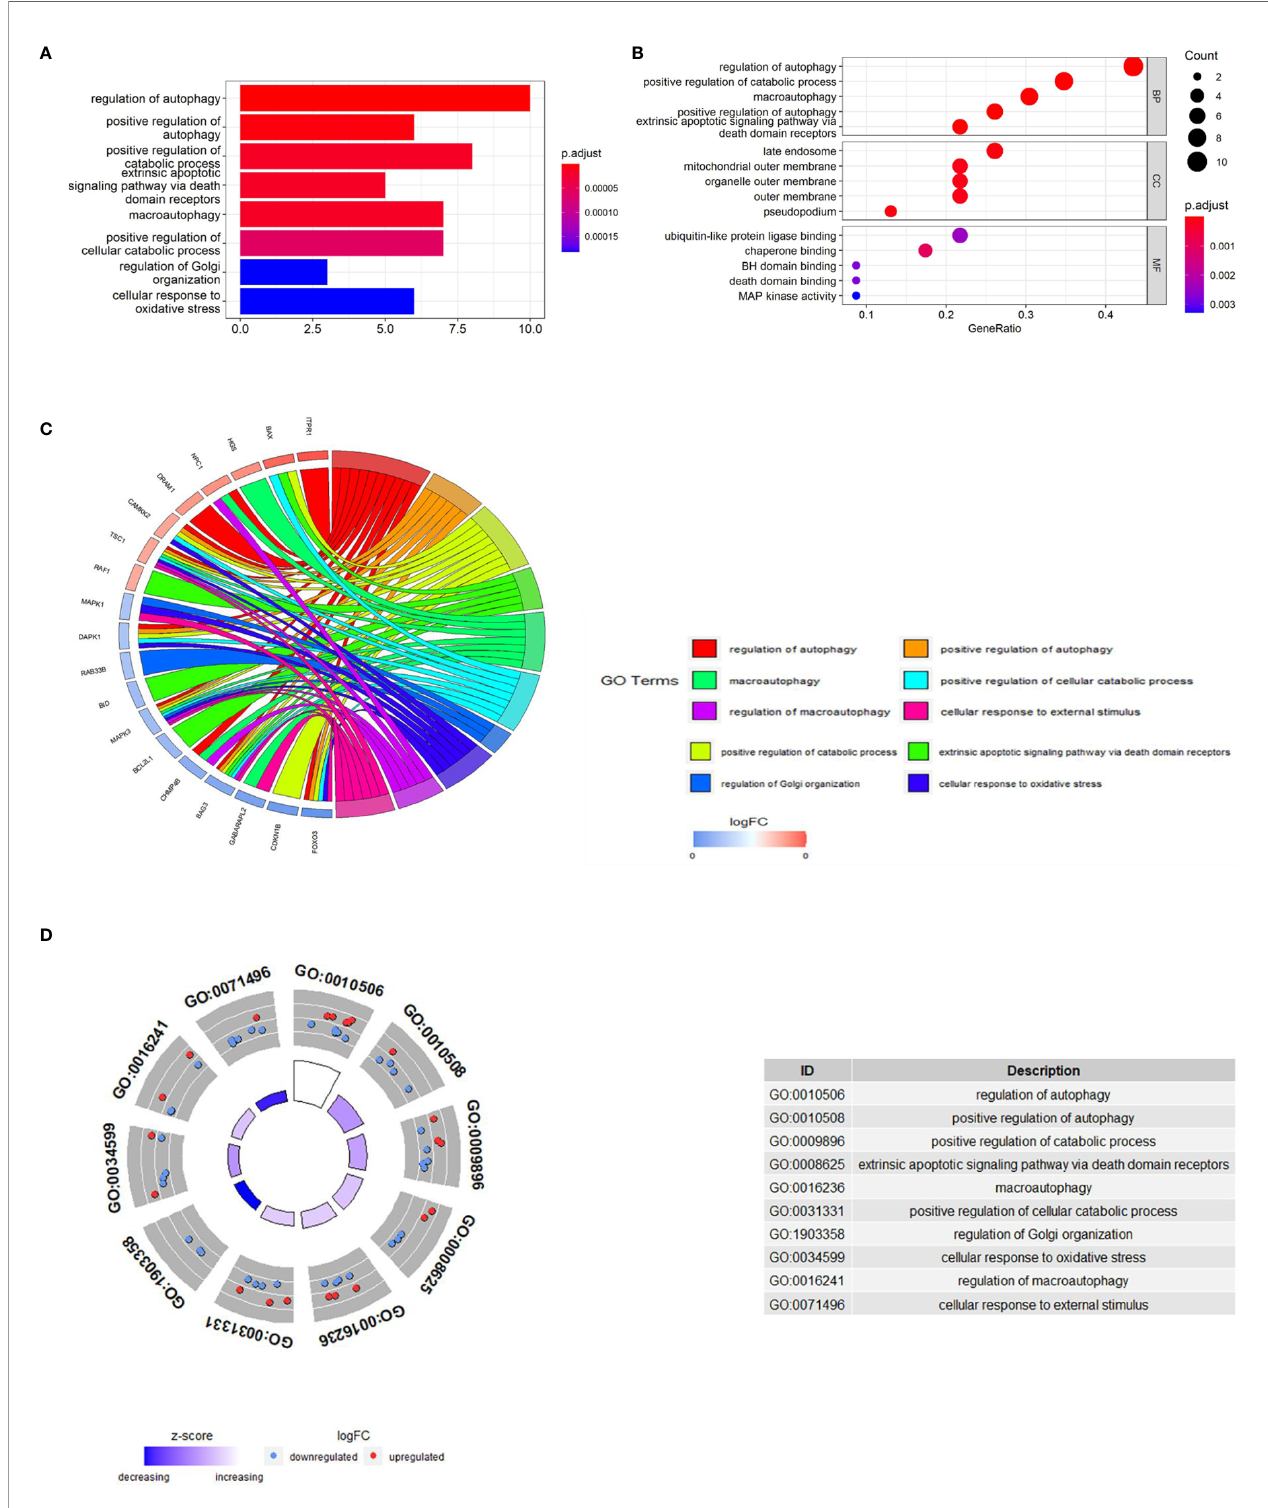
FIGURE 4 | GO enrichment analysis of 23 differentially expressed autophagy-related genes, including BPs, CCs and MFs. (A) , Bar plot of enriched GO terms. (B) , Bubble plot of enriched GO terms. (C) , Chordal graph of enriched GO terms. It shows the relationship between DEGs and the fi rst 10 enriched GO pathways. (D) , Eight Diagrams of enriched GO terms. GO, Gene Ontology; BPs, biological processes; CCs, cellular components; MFs, molecular functions; DEGs, differentially expressed